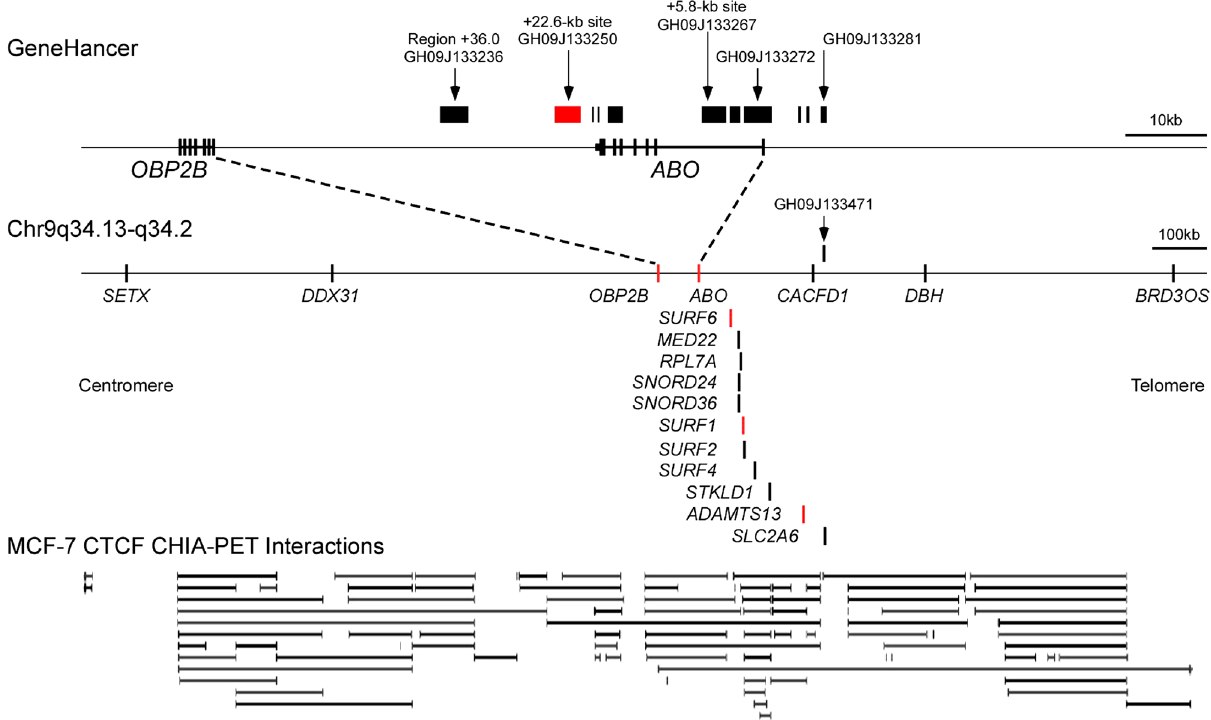
Figure 1. Schematic illustration of the relationships among the genomic regions interacting with the ABO transcription start site and the genes around ABO . The top diagram represents the genomic regions interacting with the ABO transcription start site, which were constructed using publicly available data for GeneHancer Regulatory Elements and Gene Interactions 36 . ABO and OBP2B are shown below the regions. The ABO exons are indicated by lines or a solid box, and the OBP2B exons are denoted by lines. The + 5.8-kb site is involved in GH09J133267, the + 22.6-kb site is included in GH09J133250, and the DNase I hypersensitive site region + 36.0 corresponds to GH09J133236 6,7 . The middle diagram shows the chromosomal positions of ABO and the other genes shown in Table 1, the transcription start sites of which are indicated by a line. Genes whose transcription start sites interacted with GH09J133250 are colored red. The pseudogene LCN1P1 is not shown. The